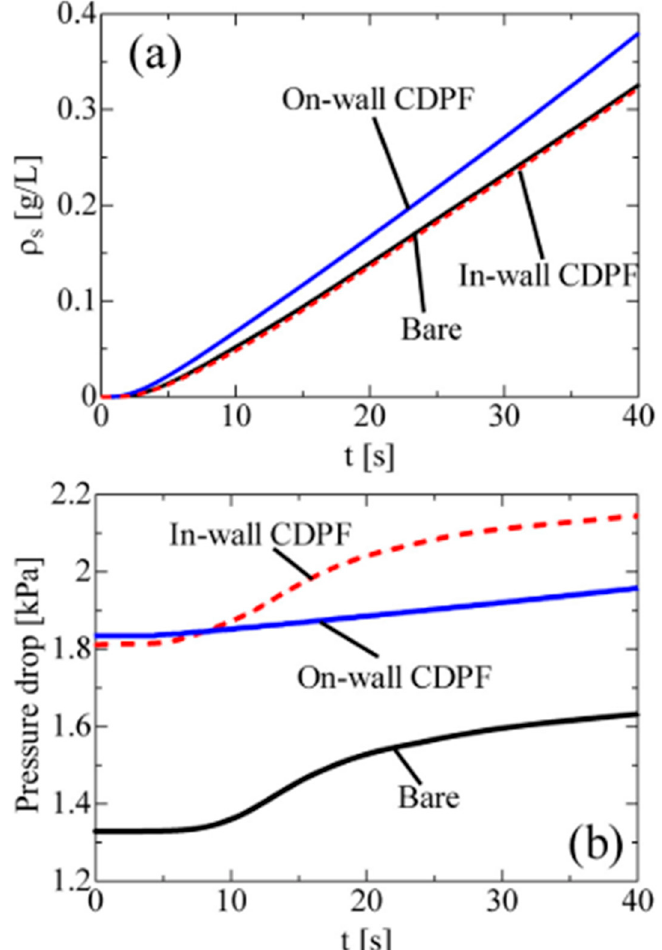
Figure 11. Time-variations of ( a ) soot amount and ( b ) pressure drop [132].